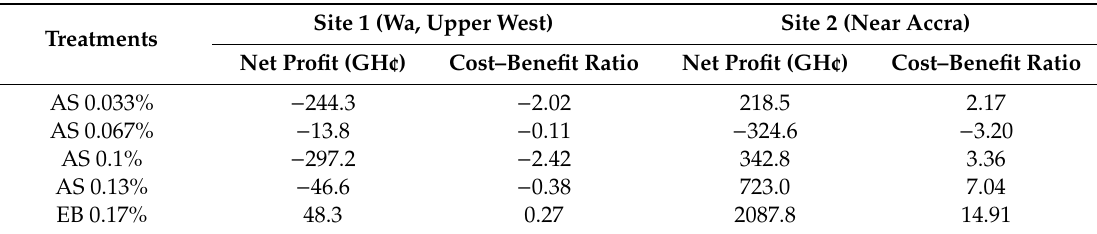
Table 4. Net profit and cost–benefit values for the e ff ect of alata samina soap treatments (AS) at four concentrations aiming to control fall armyworm in maize in Ghana compared to the negative control. Emamectin benzoate (EB) was applied as a positive